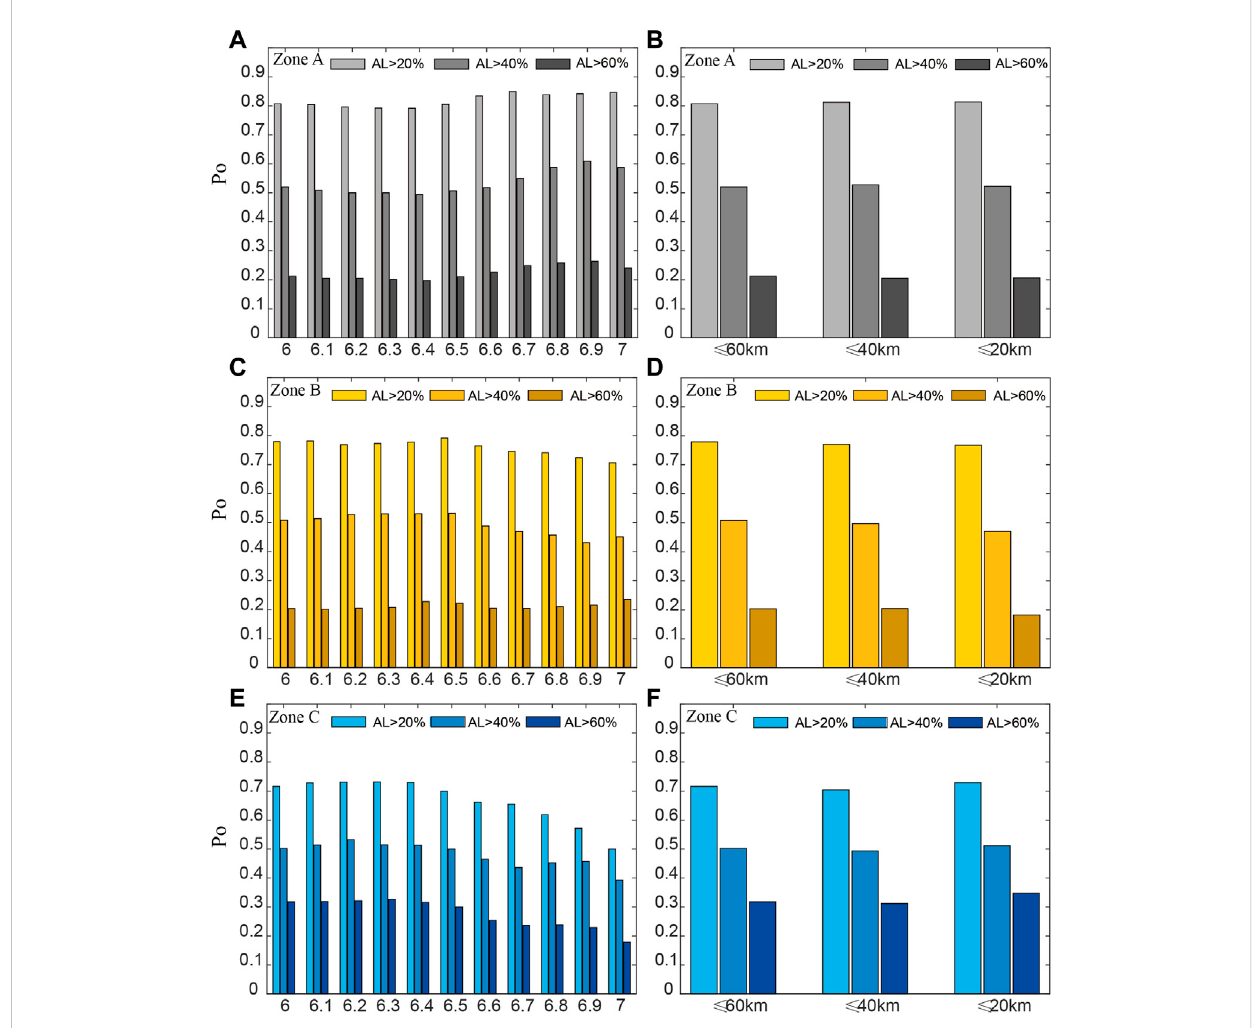
FIGURE 2 Seismo-ionospheric anomalies occurrence probabilities of AL > 20%, 40%, and 60% with different magnitudes (A, C, E) and depths (B, D, F) , respectively (15-day sliding window). (A, C) are the results in Zone A. (C, D) are the results in Zone B. (E, F) are the results in Zone C.